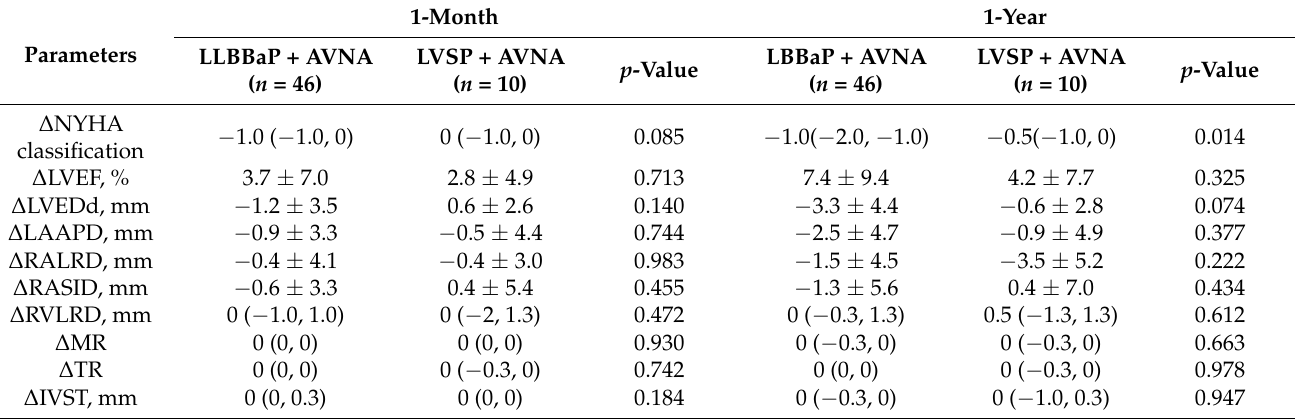
Table 5. The magnitude of improvement of NYHA classifications and echocardiographic parameters − x ± S (median (IQR, 25–75%)